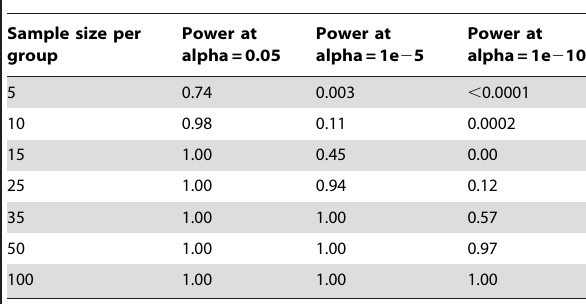
Figure S2 Supervised group comparisons reveal differences in methylation based on gender but not ethnicity. Panel (A) shows a histogram distribution of p-values calculated from an unpaired T test of males (n =4) in one group and females (n= 6) in another. Along the x-axis, leftmost data represent low p-values (i.e. highly significant differences in methylation between groups), while data towards the right represent high p-values and, thus, loci that are uniform across groups. P-value frequency is shown along the y- axis, with larger values indicating increasing numbers of differentially methylated loci corresponding to the indicated p- value level. Note that the y-axis in this panel is adjusted to a different scale in order to account for the higher frequency of highly significant p-values. Panel (B) shows an analogous histogram with data obtained from samples grouped by ethnicity (Latin, n= 7, compared to non-Latin, n= 3). Figure S3 The top-scoring molecular interaction network suggested by Ingenuity Pathway Analysis (IPA) consists of 13 genes among the top 56 differentially methylated loci. RefSeq IDs for 33 of the top 56 sites that mapped to genes were uploaded onto the ‘‘Core Analysis’’ tool of IPA. The top-scoring molecular interaction network was constructed by 35 nodes, 13 of which were located on the input list (shaded nodes), and is associated with cell signaling, nucleic acid metabolism, and molecular transport. The nodal relationships are indicated by solid lines (direct interaction) and dashed lines (indirect interactions), with or without filled arrows indicating functional interaction or merely physical association, respectively. The shape of each node indicates the class of molecule: horizontal ovals are transcription factors, squares are cytokines, vertical rectangles are G-protein coupled receptors, triangles are phosphatases, diamonds are enzymes, trapezoids are transporters, small ovals are chemicals, and circles correspond to ‘‘other’’ molecules. In alphabetical order, this network consists of ADCY, ADCY5, ADCY9, ARPC4, ATG5, b -estradiol, CAP2, CRYM, CUX2, EMILIN3, FSH, GALR1, GALR3, GH1, GJA1, GNAI2, GNAL, GNG7, GSTM3, HTR1F, LPAR4, MAMLD1, 5-methoxytryptamine, MllRN181C, NCOR2, noladin ether, PALM, PCDH19, PPP3CA, RXFP4, SH3BP4, SYP, TADA3L, and TP53. Found at: doi:10.1371/journal.pone.0008887.s003 (0.32 MB TIF) Figure S4 A molecular interaction network suggested by Ingenuity Pathway Analysis (IPA) ‘‘Core Analysis’’, with HNF4A as a central node among other transcription and growth factors. This network, associated with cancer, cellular development, cellular growth and proliferation, consists of 17 of 23 input nodes, each corresponding to the promoter of a RefSeq gene showing differential methylation by HELP. Nodes are shaded in green for relative hypermethylation in IUGR compared to controls, while red-shaded nodes are hypomethylated in IUGR. The nodal relationships are indicated by solid lines (direct interaction) and dashed lines (indirect interactions), with or without filled arrows indicating functional interaction or physical association, respec- tively. The shape of each node indicates the class of molecule: horizontal ovals are transcription factors, squares are growth factors, vertical rectangles are ion channels, triangles are phosphatases, diamonds are enzymes, trapezoids are transporters, and circles correspond to ‘‘other’’ molecules with concentric circles indicated complexes. In alphabetical order, this network consists of ADCY5, ARPC4, ATG5, b -estradiol, BUD31, C11ORF10, C9ORF5, Ca2 + , CDKN2A, CHCHD8, CPA2, CPN1, CRY1, CTNNBL1, CUX2, FSH, GATA2, GH1, GINS3, GRIK4, HNF4A, INO80D, NCOR2, PPP3CA, PRSS3, RUVBL2,